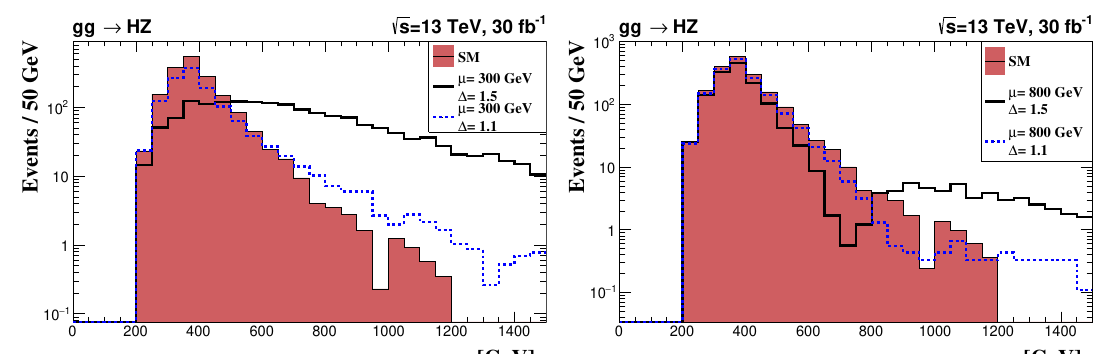
Figure 17. gg ! hZ .